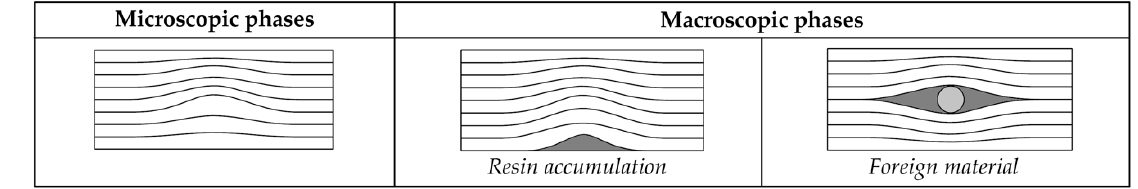
Figure 35. Microscopic vs. macroscopic distributed phases in wavy regions.